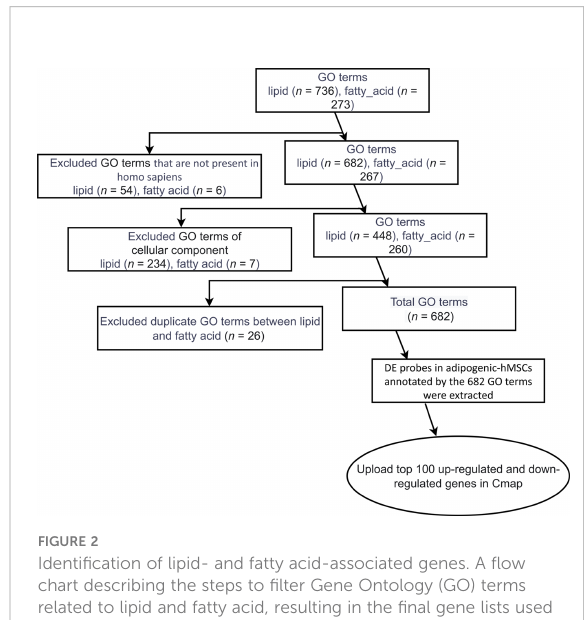
FIGURE 2 Identi fi cation of lipid- and fatty acid-associated genes. A fl ow chart describing the steps to fi lter Gene Ontology (GO) terms related to lipid and fatty acid, resulting in the fi nal gene lists used for CMap